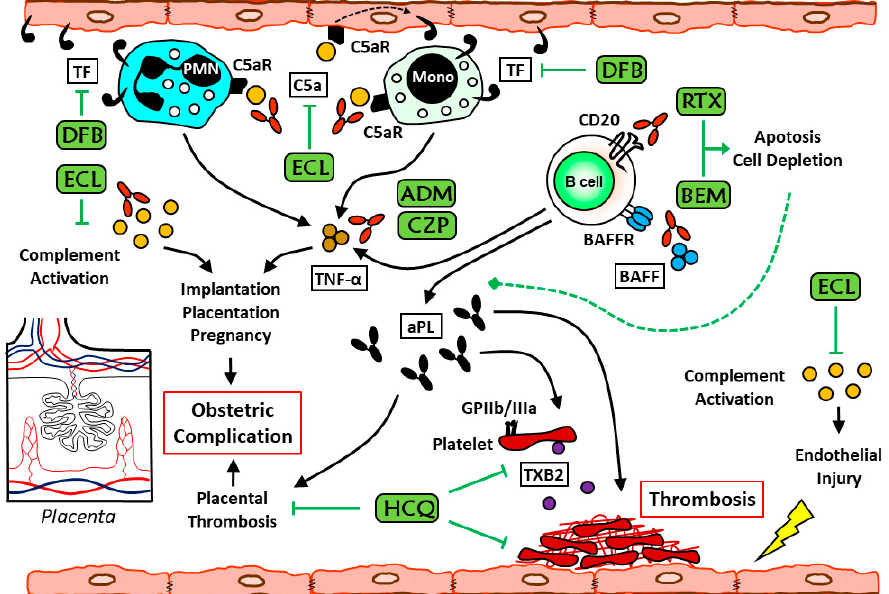
Figure 1. Main pathogenetic pathways in antiphospholipid syndrome (APS) and possible molecular targets of the immunological therapy. ADM: Adalimumab; BEM: belimumab; CZP: certolizumab; ECL: eculizumab; DFB: defibrotide; GPIIb/IIa: Glycoprotein IIb/IIIa; HCQ: hydroxychloroquine; RTX: rituximab; TF: tissue factor; TXB2: Thromboxane B2.